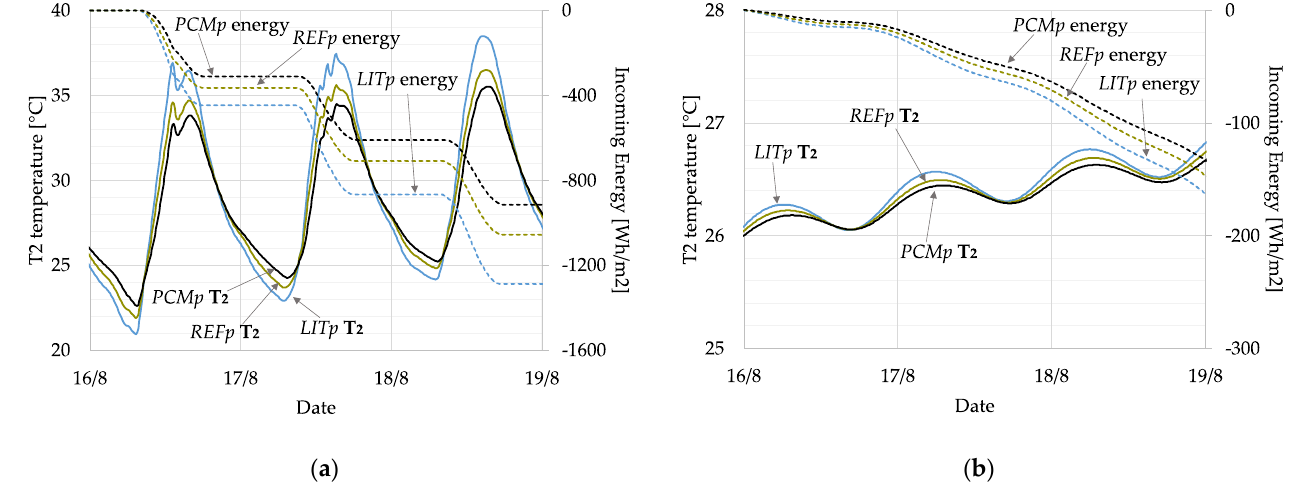
Figure 11. ( a ) Temperatures and incoming energy between the outer plaster and the 0.38 m brick layer (sensors T 2 and HF 5 ); ( b ) temperatures and incoming energy between the 0.38 m brick layer and the inner plaster (sensors T 3 and HF 6 ).